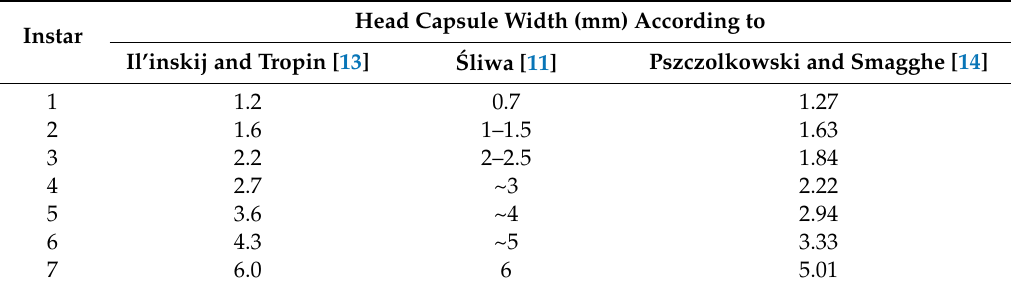
Table 1. Mean head capsule widths of Dendrolimus pini larvae given in the literature. Head Capsule Width (mm) According Instar